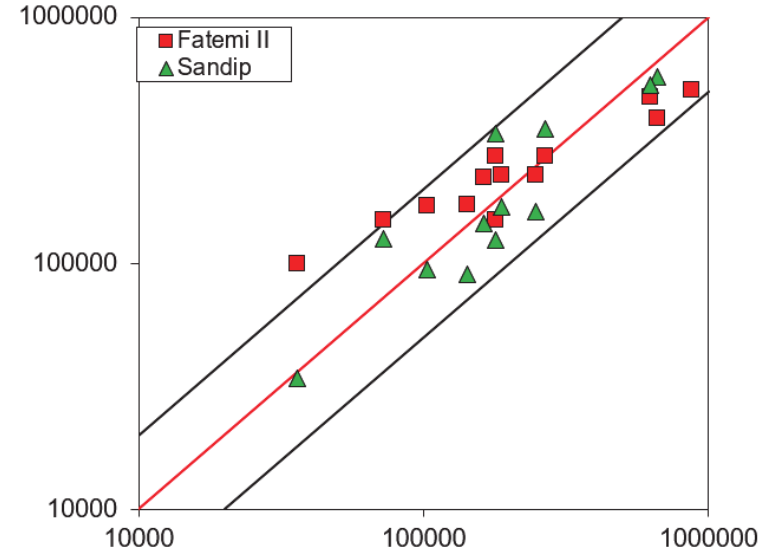
Figure 6: Predicted vs. experimental life for St52-3N using Fatemi II model and Sandip